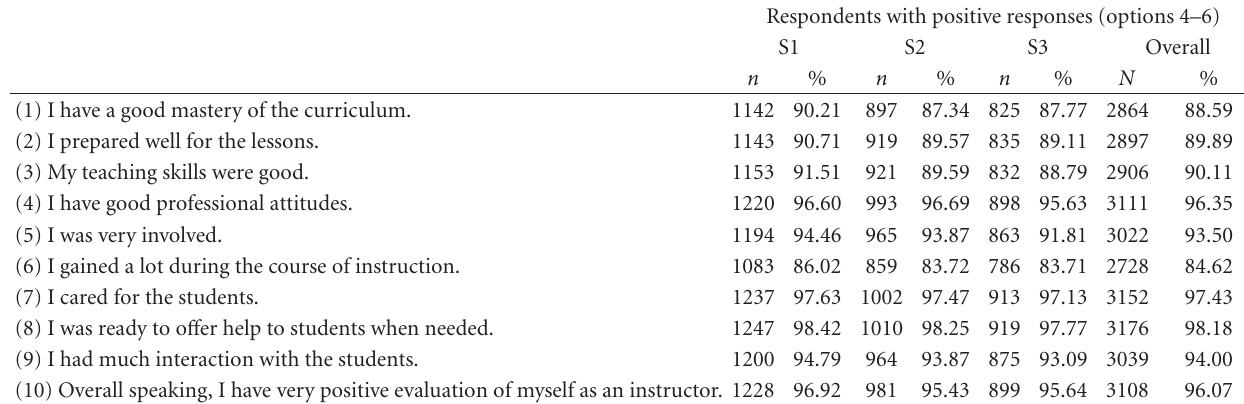
Table 2: Summary of the program implementers’ perception towards their own